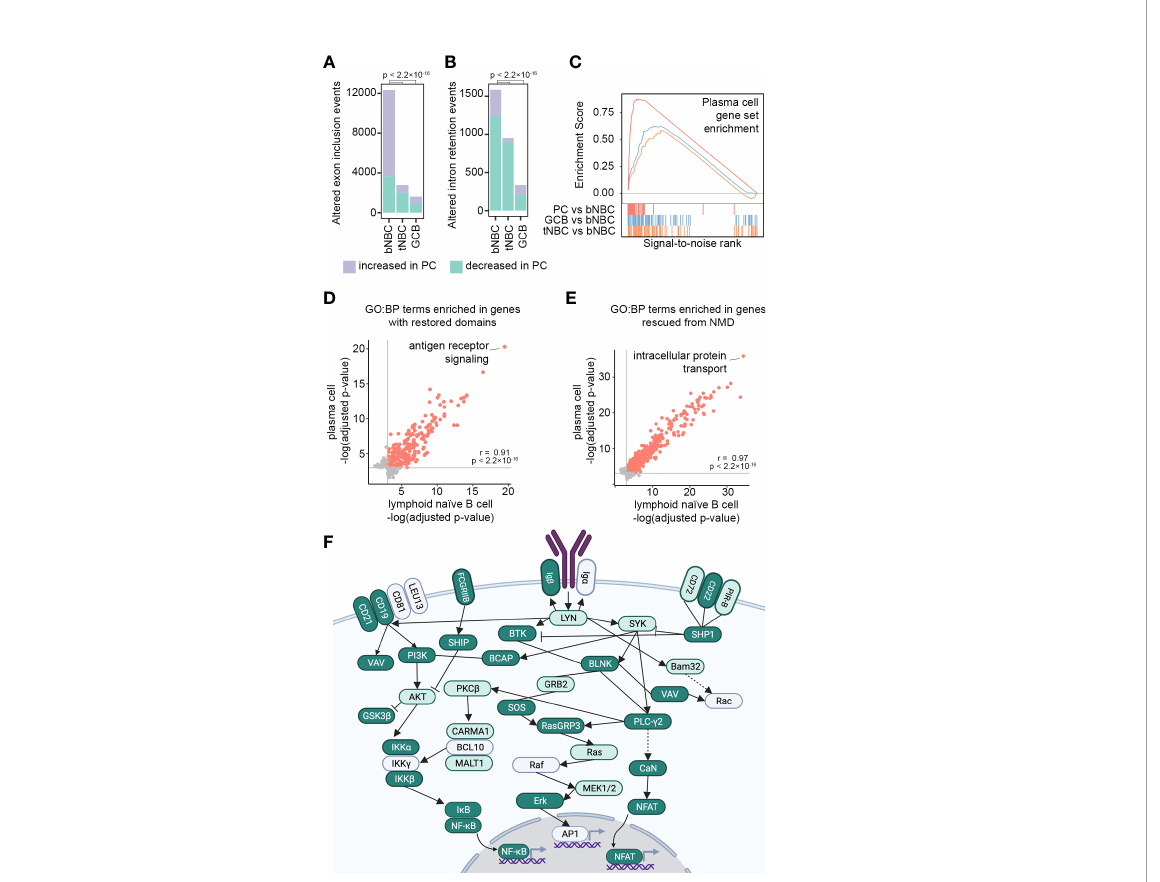
FIGURE 5 Lymphoid tissue-associated splicing repair prepares naïve B cells for antigen encounter. (A) Exon usage changes (rMATS FDR < 0.05, | IncLevelDifference| ≥ 0.1) in blood NBCs (bNBC), lymphoid (tonsil) NBCs (tNBC) and GC B cells (GCB) compared to PCs. P-values calculated by Pearson ’ s Chi-squared test with Yates ’ continuity correction. (B) Intron retention changes (rMATS FDR < 0.05, |IncLevelDifference| ≥ 0.1) in blood NBCs (bNBC), tonsil NBCs (tNBC) and GC B cells (GCB) compared to PCs. P-values calculated by Pearson ’ s Chi-squared test with Yates ’ continuity correction. (C) Enrichment scores from GSEA of RNA abundance changes in PCs (red, maximum enrichment score = 0.880, p = 0), GC B cells (GCB, blue, maximum enrichment score = 0.627, p = 0.001) or tonsil NBCs (tNBC, orange, maximum enrichment score = 0.588, p = 0.021) compared to blood NBCs. Gene set: TARTE_PLASMA_CELL_VS_B_LYMPHOCYTE_UP from MSigDB. Colored vertical lines indicate genes in the gene set. (D) GO Biological Process term enrichment in genes with conserved protein domains restored by exon inclusion i lymphoid (tonsil) NBCs or in PCs compared to blood NBCs. All signi fi cantly enriched terms (adjusted p-value < 0.05) are shown. Grey lines indicate adjusted p-value = 0.05. Red points: signi fi cant enrichment in both PCs and lymphoid NBCs. Grey points: signi fi cant enrichment in lymphoid NBCs or PCs only. Correlation (r) and p-value calculated using Pearson ’ s product-moment correlation. Full GO term information is shown in Supplemental Table 8. (E) GO Biological Process term enrichment in genes with NMD targeting reduced by exon inclusion